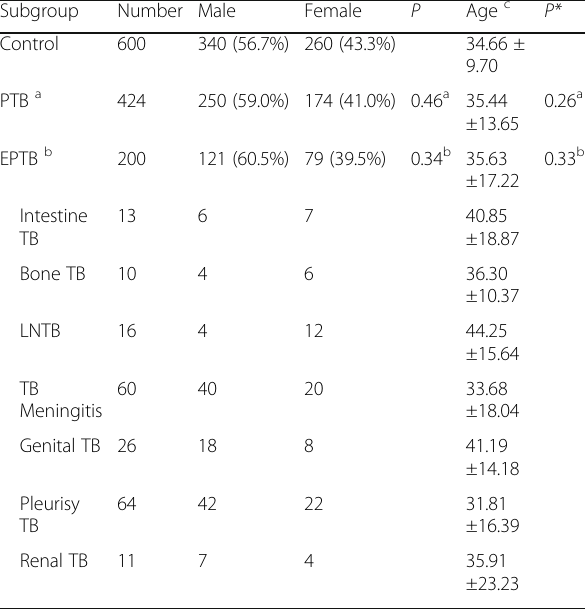
a PTB pulmonary tuberculosis patients b EPTB extra-pulmonary tuberculosis patients -value calculated by t -test for age between TB patients and